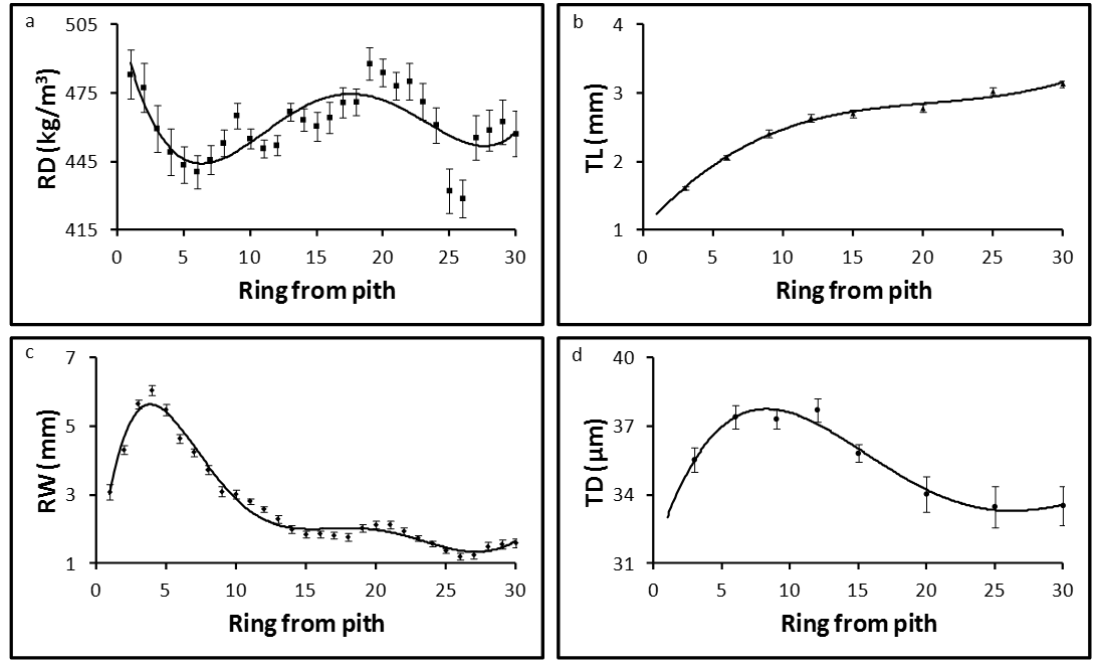
Figure 2. Radial variation pattern of selected wood quality attributes with standard errors (SE) bars: ( a ) radial variation of ring density (RD), ( b ) radial variation of tracheid length (TL), ( c ) radial variation of ring width (RW), ( d ) radial variation of tracheid diameter (TD).